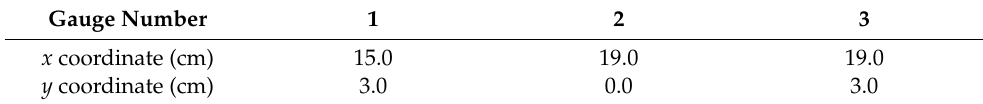
Table 1. The coordinates of the gauges.